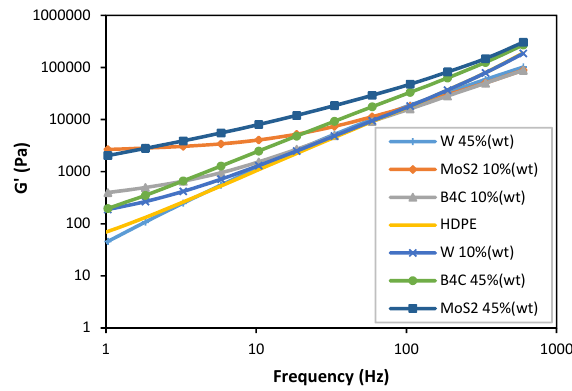
Fig. 11. Storage modulus curves vs frequency at 200 o C.